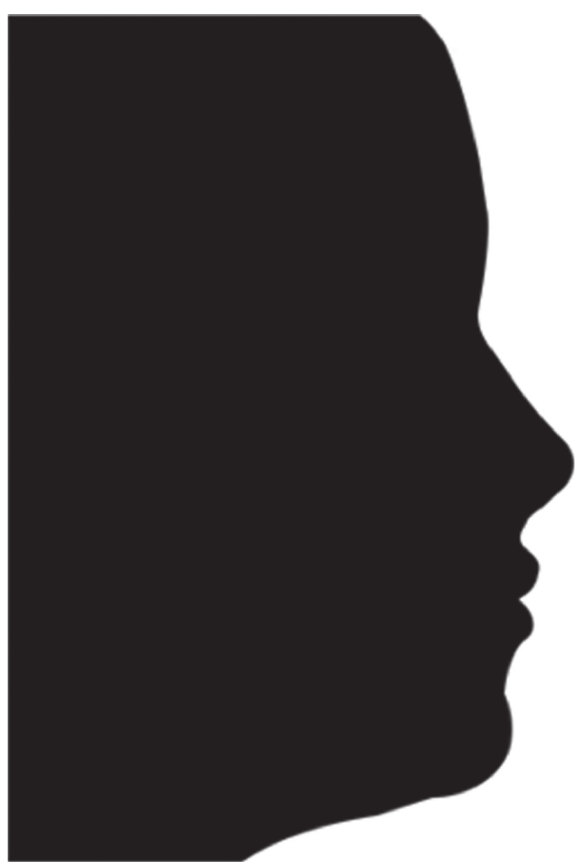
Figure 3: Facial profile silhouette.